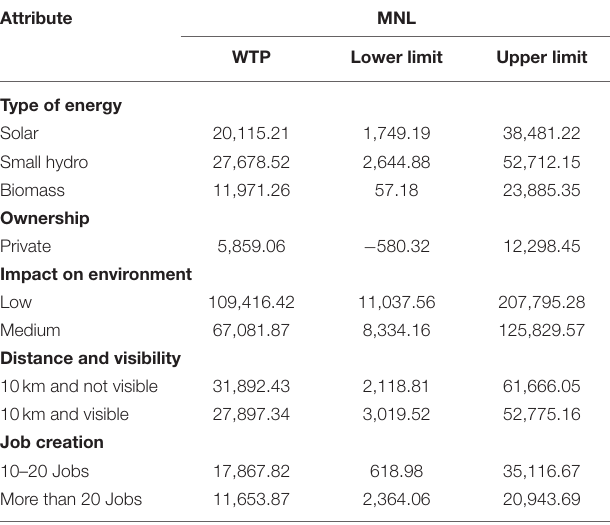
TABLE 6 | Marginal willingness to pay estimate (95% confidence